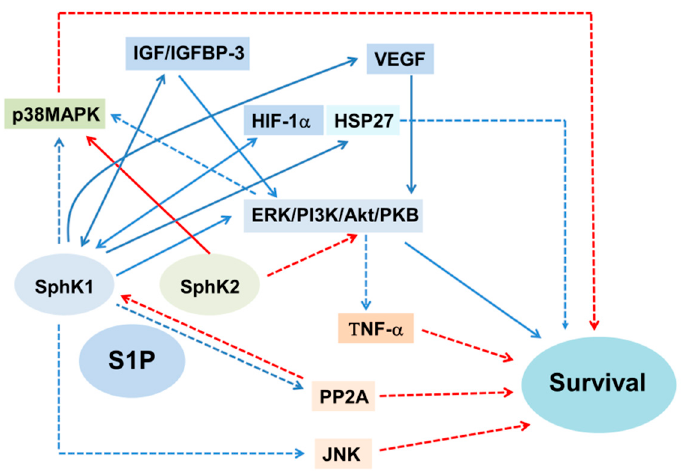
Figure 7. S1P-induced signaling pathways regulate cell survival in oxidant-induced kidney injury. SphK1 prevents ROS-induced apoptosis by activating pro-survival HIF-1 α /HSP27. HIF-1 α activates SphK1. SphK1 functions as anti-apoptotic by activating ERK/PI3K/Akt/PKB and by inhibiting apoptotic p38MAPK, while SphK2 has the opposite effect. Conversely, ERK activates SphK1. SphK1 activates IGF/IGFBP-3 and vice versa and VEGF, ameliorating ROS-induced apoptosis by activating ERK/PI3K/Akt/PKB. SphK1 inhibits JNK and PP2A, thereby inhibiting apoptosis. Conversely, PP2A inhibits SphK1, leading to apoptosis. Abbreviations; HIF; hypoxia-inducible factor, HSP; heat-shock protein, IGF; insulin growth factor, IGFBP-3; IGF binding protein-3, PI3K; phosphatidylinositol 3-kinase, PKB; protein kinase B, TNF; tumor necrosis factor. Red arrow; apoptotic pathway, blue arrow; anti-apoptotic pathway, → ; stimulation, dashed arrow;